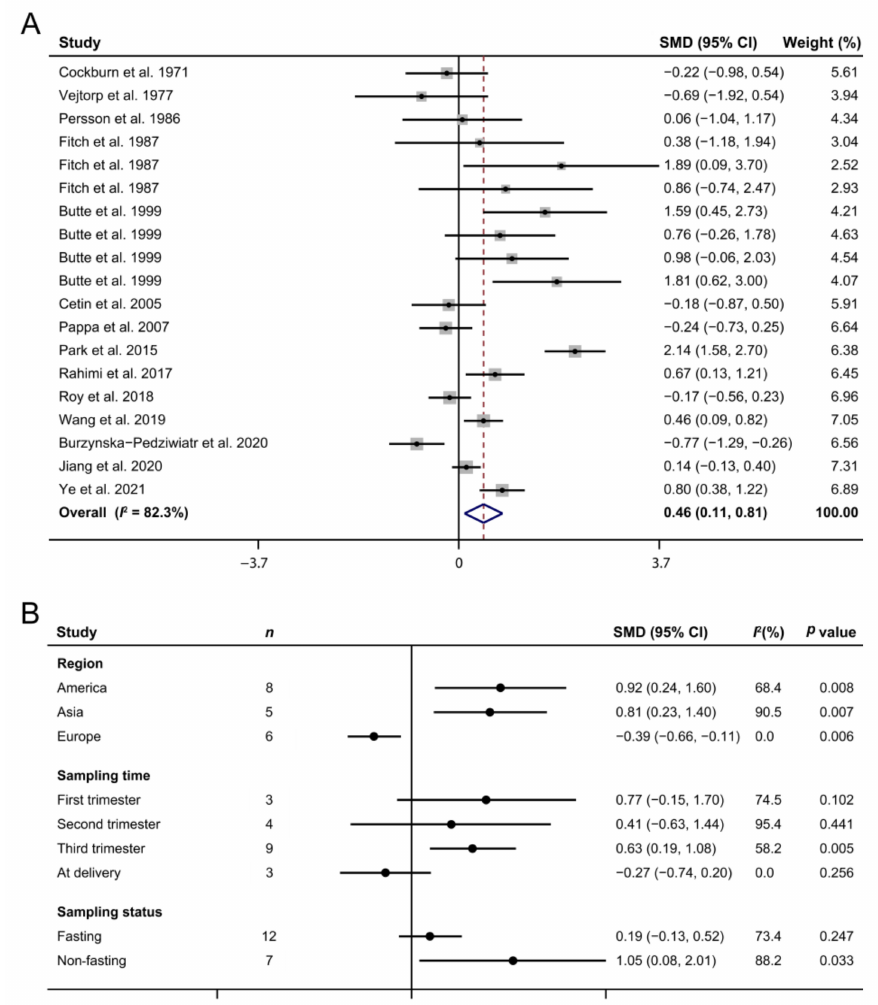
Figure 4. The forest plot exhibits the maternal arginine concentrations in gestational diabetes mellitus pregnancies ( A ) as well as their subgroup analyses ( B ). The solid black circles mean the estimate of SMD. The horizontal lines indicate the 95% CI of this effect, and the sizes of the gray boxes suggest the relative weight of each publication. An open diamond denotes the overall SMD determined using a random effects model. The value on the x-axis corresponds to the SMD of maternal arginine concentration. Heterogeneity among the publications was estimated using the I 2 statistic, with 0–25%, 25.1–75%, and 75.1–100% representing low, moderate, and high degrees of heterogeneity, respectively. SMD, standard mean